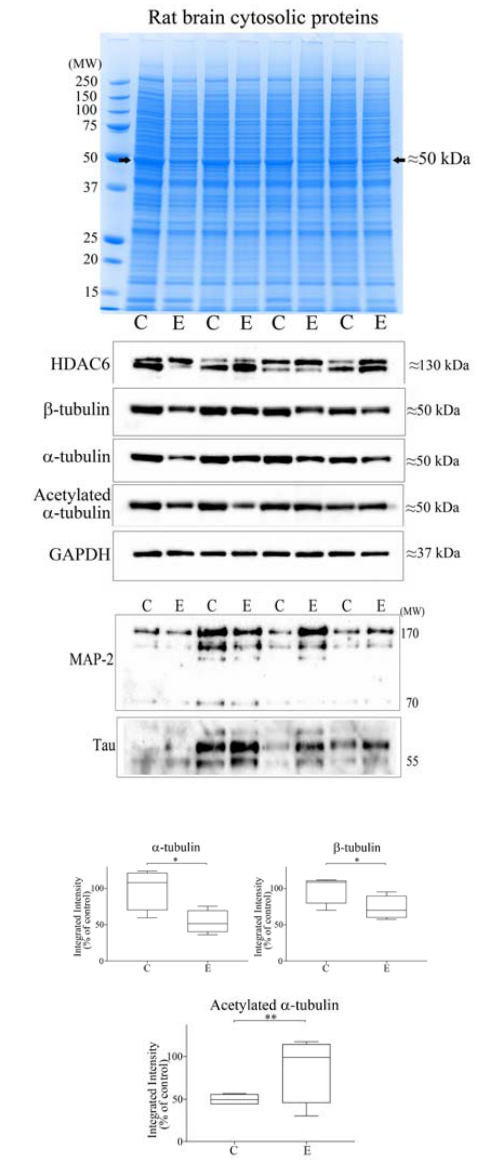
Figure 5. Profiling of brain cytoplasmic proteins from control (C) and ethanol-fed (E) rats, and Western blotting. ( A ) Brain cytosolic proteins from control (C) or ethanol-fed (E) rats resolved by one dimensional polyacrylamide gel electrophoresis were stained with Coomassie (upper panel). Protein staining at ≈ 50 kDa (marked with an arrowhead) was reduced in ethanol-fed rats. Proteins were Western blotted using a panel of antibodies (middle and lower panels). ( B ) Western blots were quantified by densitometry, with GAPDH levels used for blot normalization, and data presented as box plots. For marked significance: * = p < 0.05, ** = p < 0.01. Control values were set at